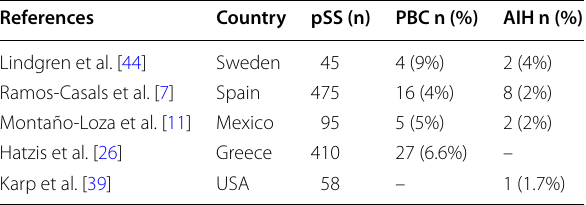
Table 2 Prevalence of PBC and AIH in patients with pSS